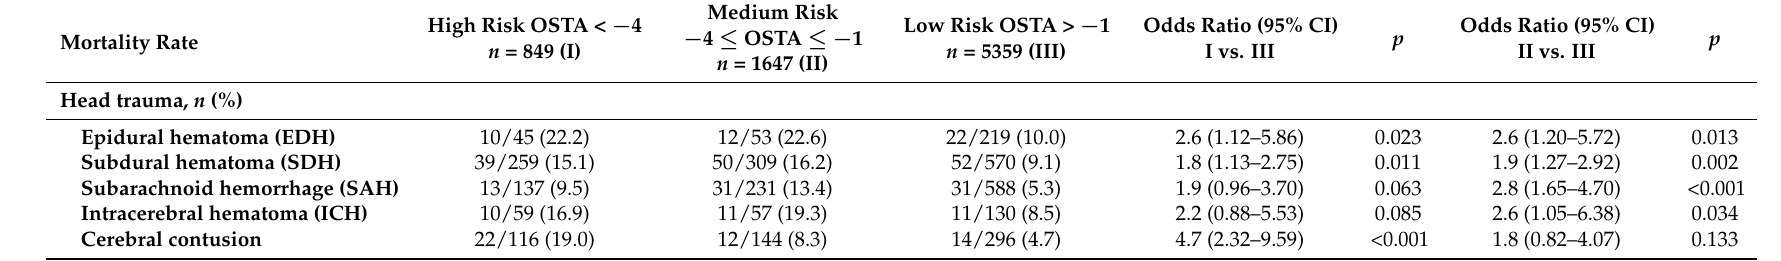
Table 2. Mortality rate of different types of trauma injury to the brain in high-risk, medium-risk, and low-risk patients.